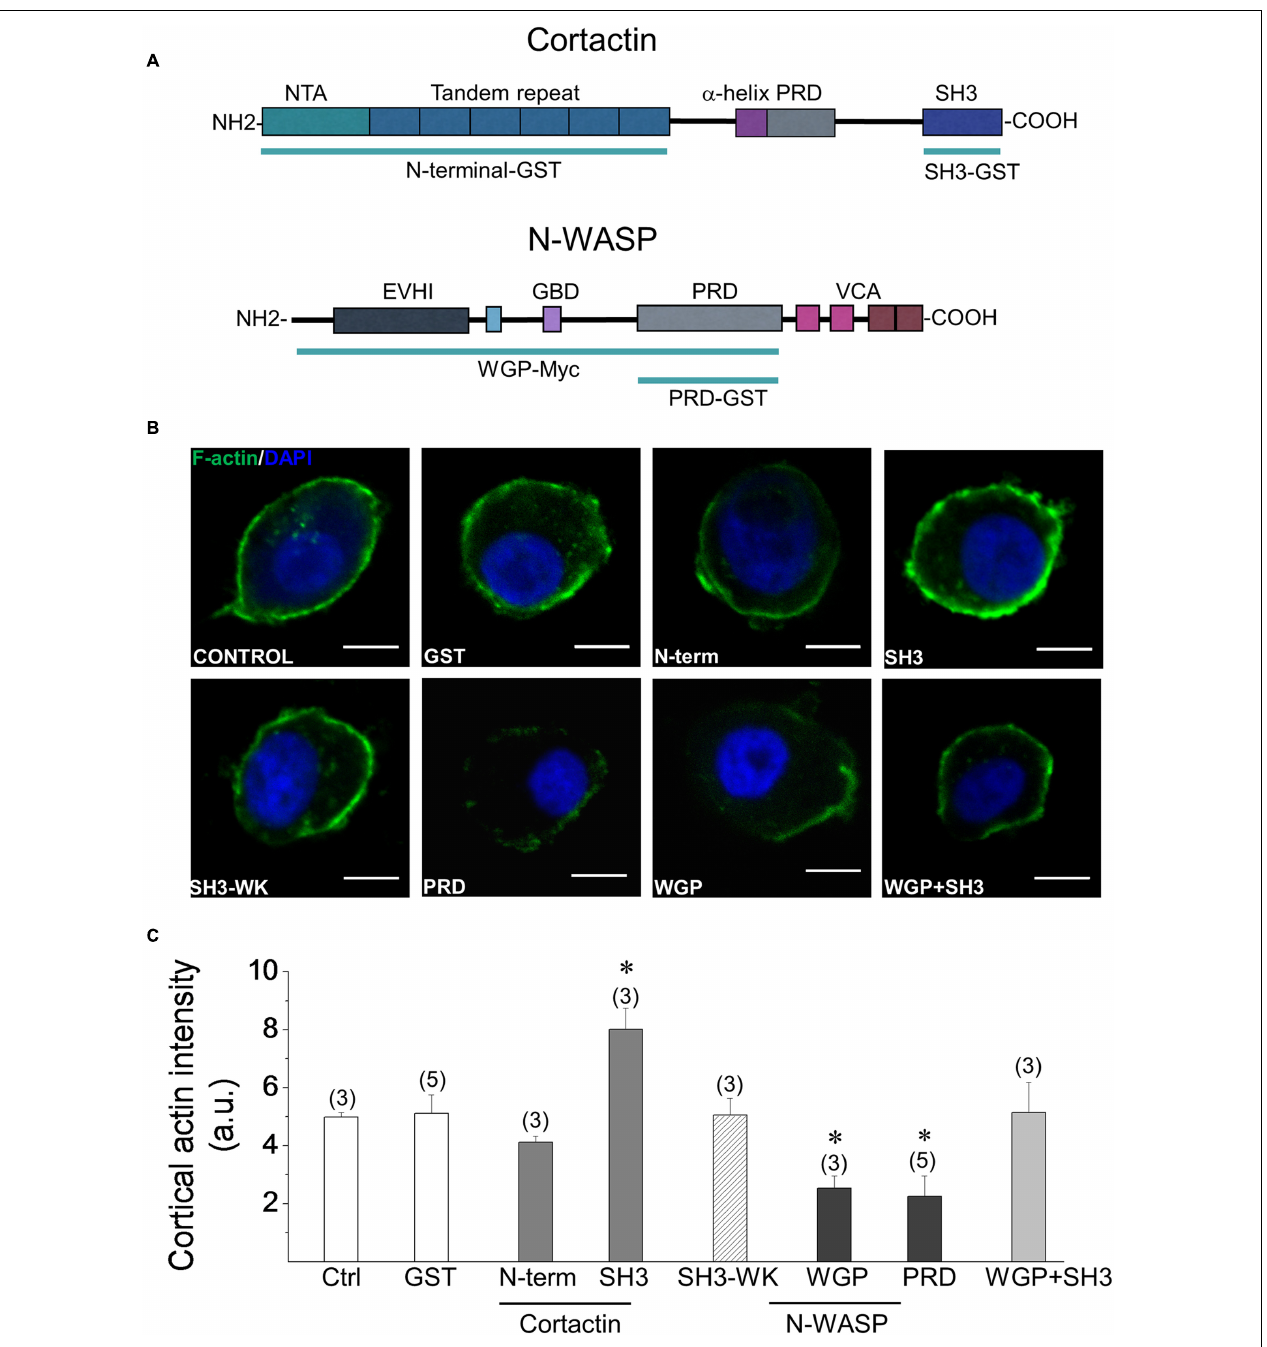
FIGURE 2 | Effects of the cortactin SH3 domain and the N-WASP PRD on Ca 2 + -induced cortical F-actin formation. (A) Schematic representation of cortactin and N-WASP primary structures. The cortactin N-terminal region contains the N-terminal acidic domain (NTA), which binds and activates the Arp2/3 complex, and the tandem repeat that binds F-actin. The WGP fragment of N-WASP consists in the protein lacking the VCA region (B,C) . F-actin polymerization assay was performed in cells permeabilized with 20 µ M digitonin, in the presence of 300 nM Alexa-Fluor-488 actin, 2 mM ATP-Mg 2 + , 10 µ M free Ca 2 + and 100 nM of GST alone or the indicated fusion peptide. Then samples were fixed, stained with DAPI and visualized by confocal microscopy. (B) Representative images of F-actin formation. Scale bar = 10 µ m. (C) The graph corresponds to quantification of the fluorescence intensity of cortical actin filaments 1 µ m under the cell periphery. Data are means ± SEM from cells permeabilized in the absence of peptides (control; n = 16) or in the presence of GST ( n = 43), GST-cortactin N-terminal (N-term; n = 21), GST-cortactin SH3 (SH3; n = 54), GST-cortactin SH3W525K mutant (WK; n = 38), Myc-tagged N-WASP WGP (WGP; n = 11), GST-N-WASP PRD (PRD; n = 33) or GST-cortactin SH3 plus Myc-tagged N-WASP WGP (WGP+SH3; n = 25). N corresponds to the number of tested cells per experimental condition from at least three different cultures (numbers over the bars indicate the number of cell cultures). Statistical significance was determined by one-way ANOVA followed by unpaired t -test where ∗ p < 0.05 compared with control cells (Ctrl).